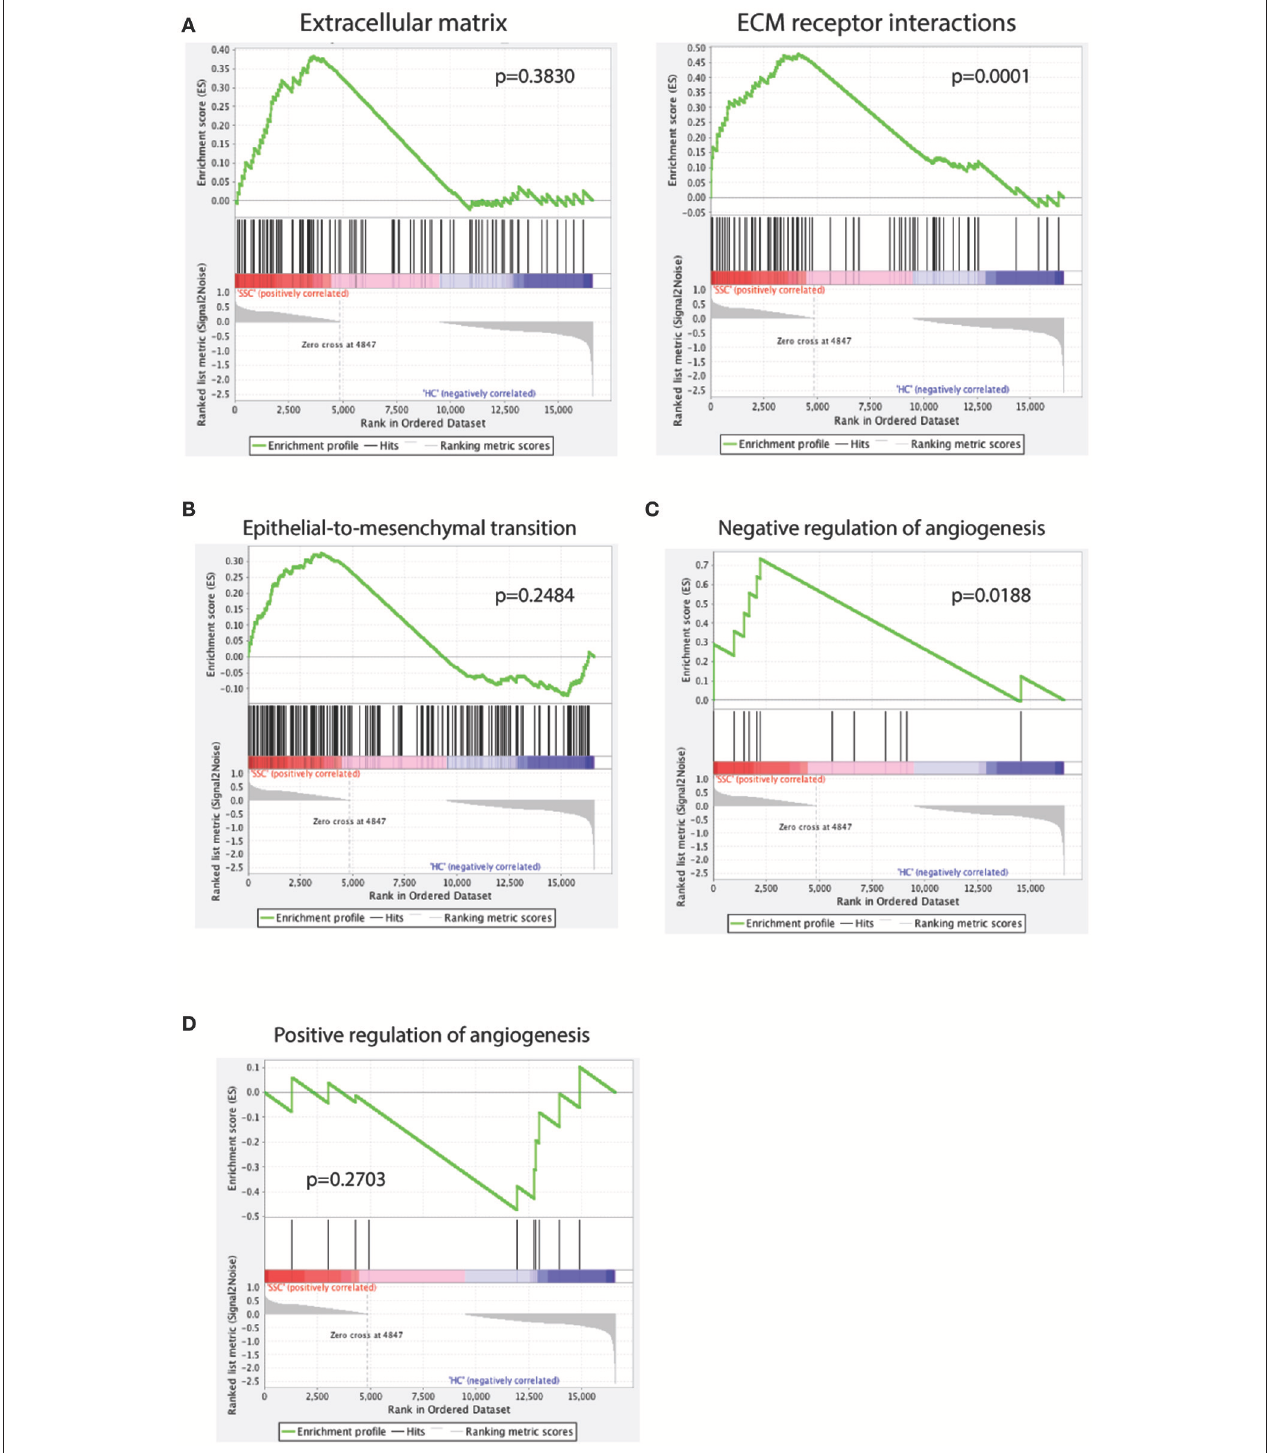
FIGURE 3 | GSEA analysis of the scRNAseq dataset against the GSEA geneset for extracellular matrix ( A , left) and extracellular matrix (ECM) receptor interactions ( A , right), epithelial-to-mesenchymal transition (B) , negative regulation of angiogenesis (C) and positive regulation of angiogenesis (D) . A positive enrichment score on the y-axis indicates positive correlation with the SSc endothelial cell group and a negative enrichment score indicates a negative correlation.